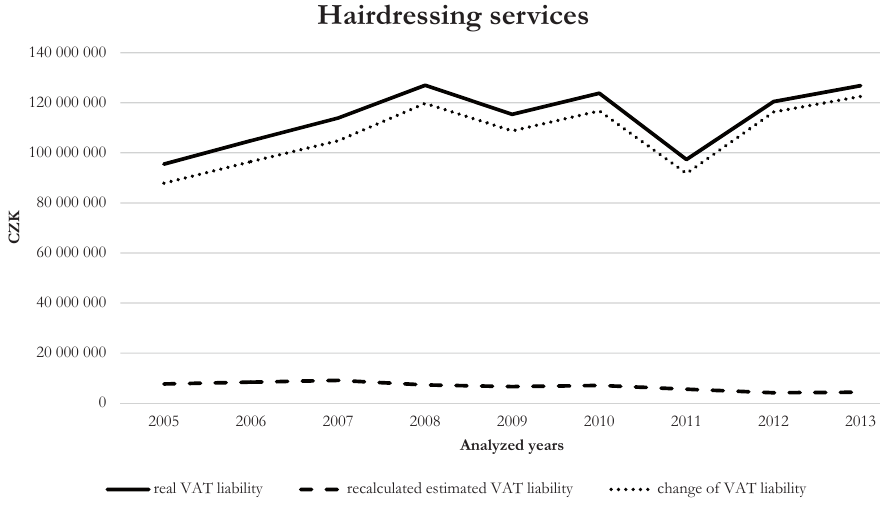
Fig. 2 - Real and recalculated estimated VAT liability of hairdressing services and its change. Source: Authors´ calculation according to the questionnaire research and